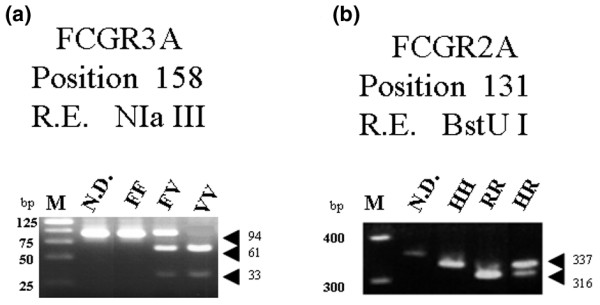
PCR-RFLP analysis of the FCGR3A and FCGR2A genes. cDNA was amplified with primers and restriction digested using appropriate enzymes. Digested PCR products were visualized with ethidium bromide. (a) FCGR3A gene and (b) FCGR2A gene. ND, nondigested PCR product; RE, restriction enzyme.